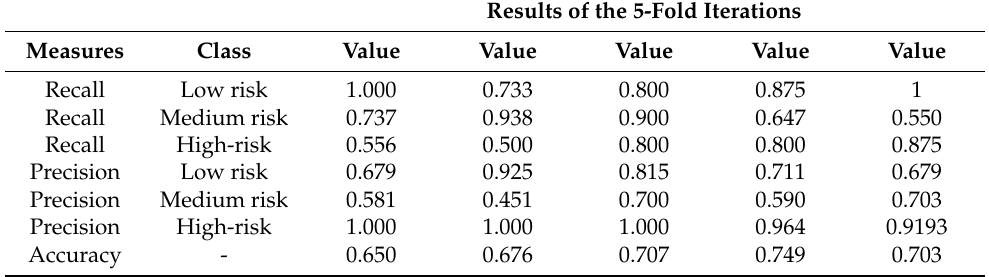
Table 4. Results of the 5-fold iterations.